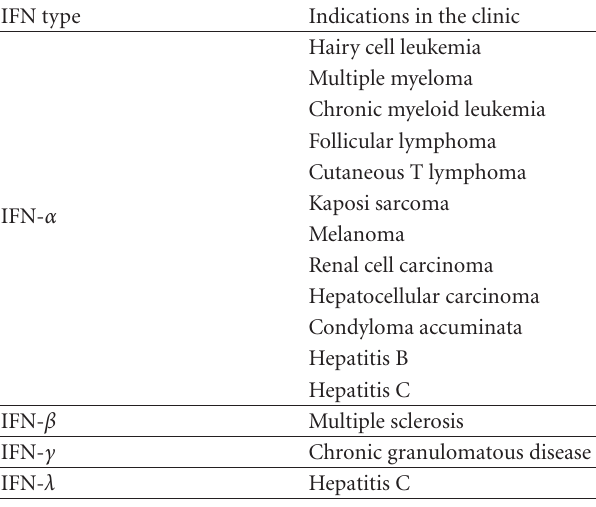
Table 1: Clinical indications of IFNs. IFN- α with di ff erent trade names is the most indicated in the clinic. IFN- β is mostly indicated for the treatment of relapsing remitting multiple sclerosis. IFN- γ is only indicated for the chronic granulomatous disease. IFN- λ , the new type of IFN, was tested for patients with chronic hepatitis